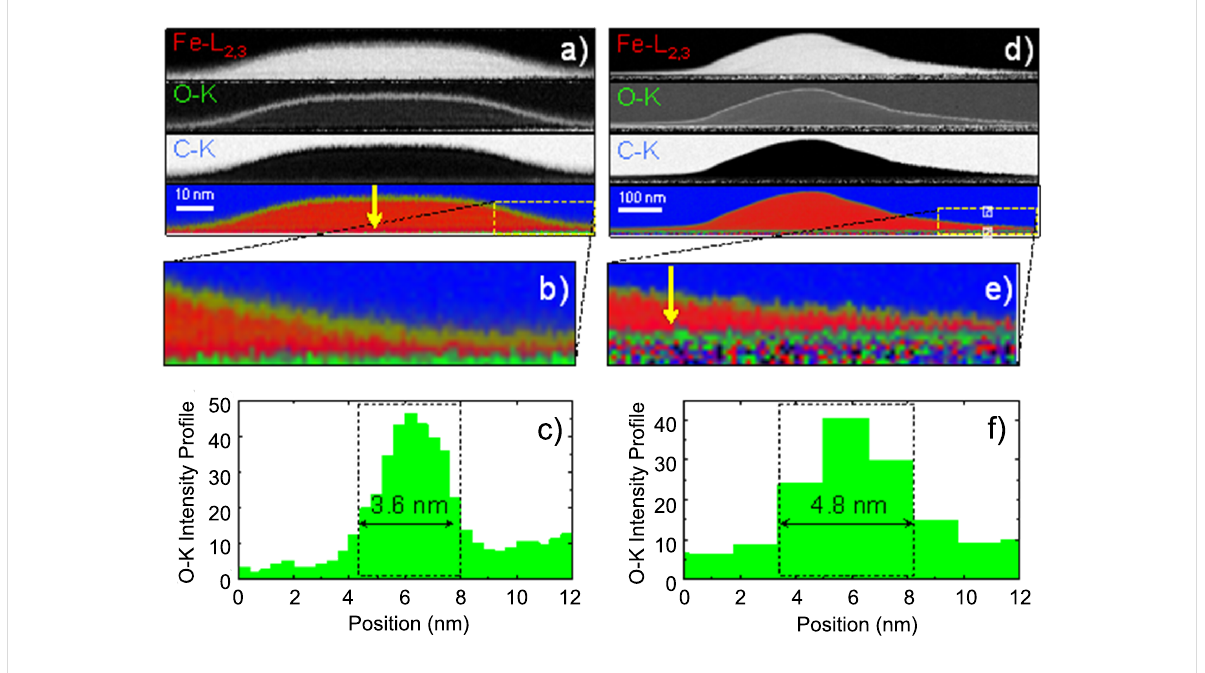
Figure 4: Compositional analysis through EELS of the iron nanowires with nominal thickness of (a) 10 nm and (d) 45 nm. In (b) and (e) a close-up of the corresponding halos is shown. In (c) and (f) the intensity profiles of the oxygen from above the surface towards the interior part of the two nanowires (at the positions marked with yellow arrows) are shown: The thickness of the oxidized surface layer (FeO) is around 4–5